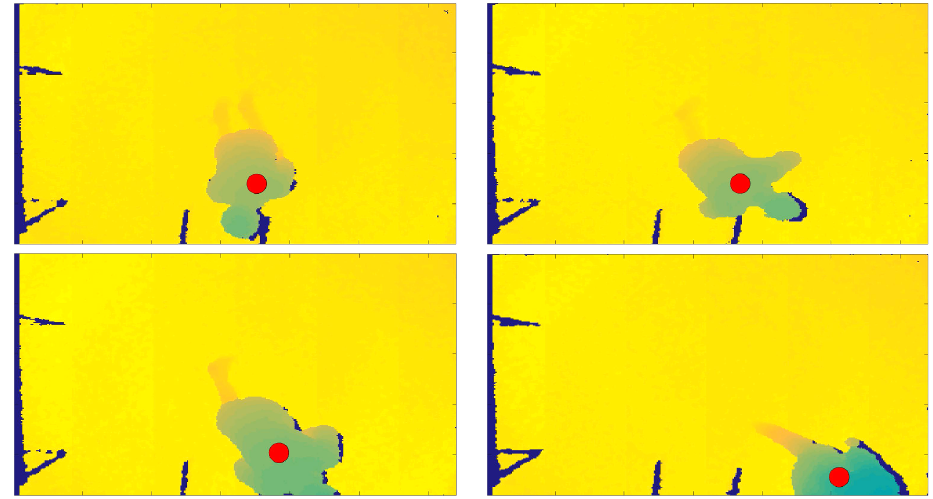
Figure 3. Recovery phase of the FFOKCHSTRC sequence simulated by ES 01, where the person left the scene after a fall without the correct acquisition of the initial height. The dot is a marker that identifies a fall when it is red.